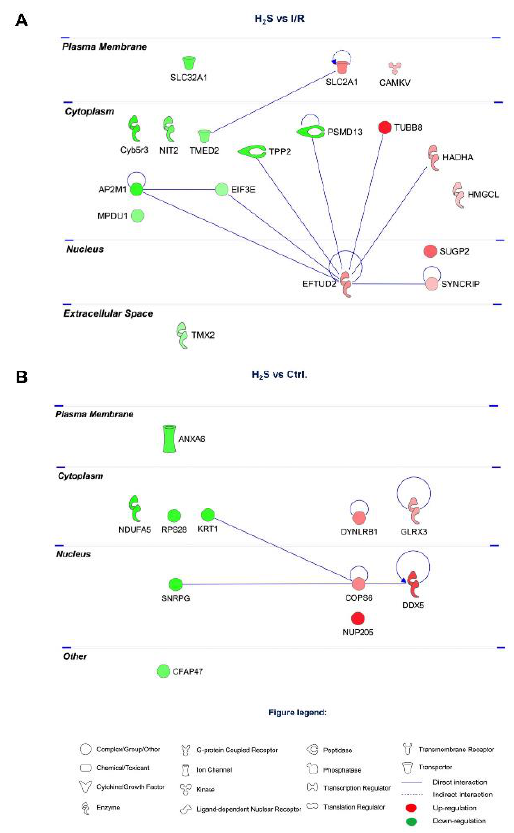
Figure 5. Protein–protein interaction networks of the di ff erentially expressed retinal proteins modulated